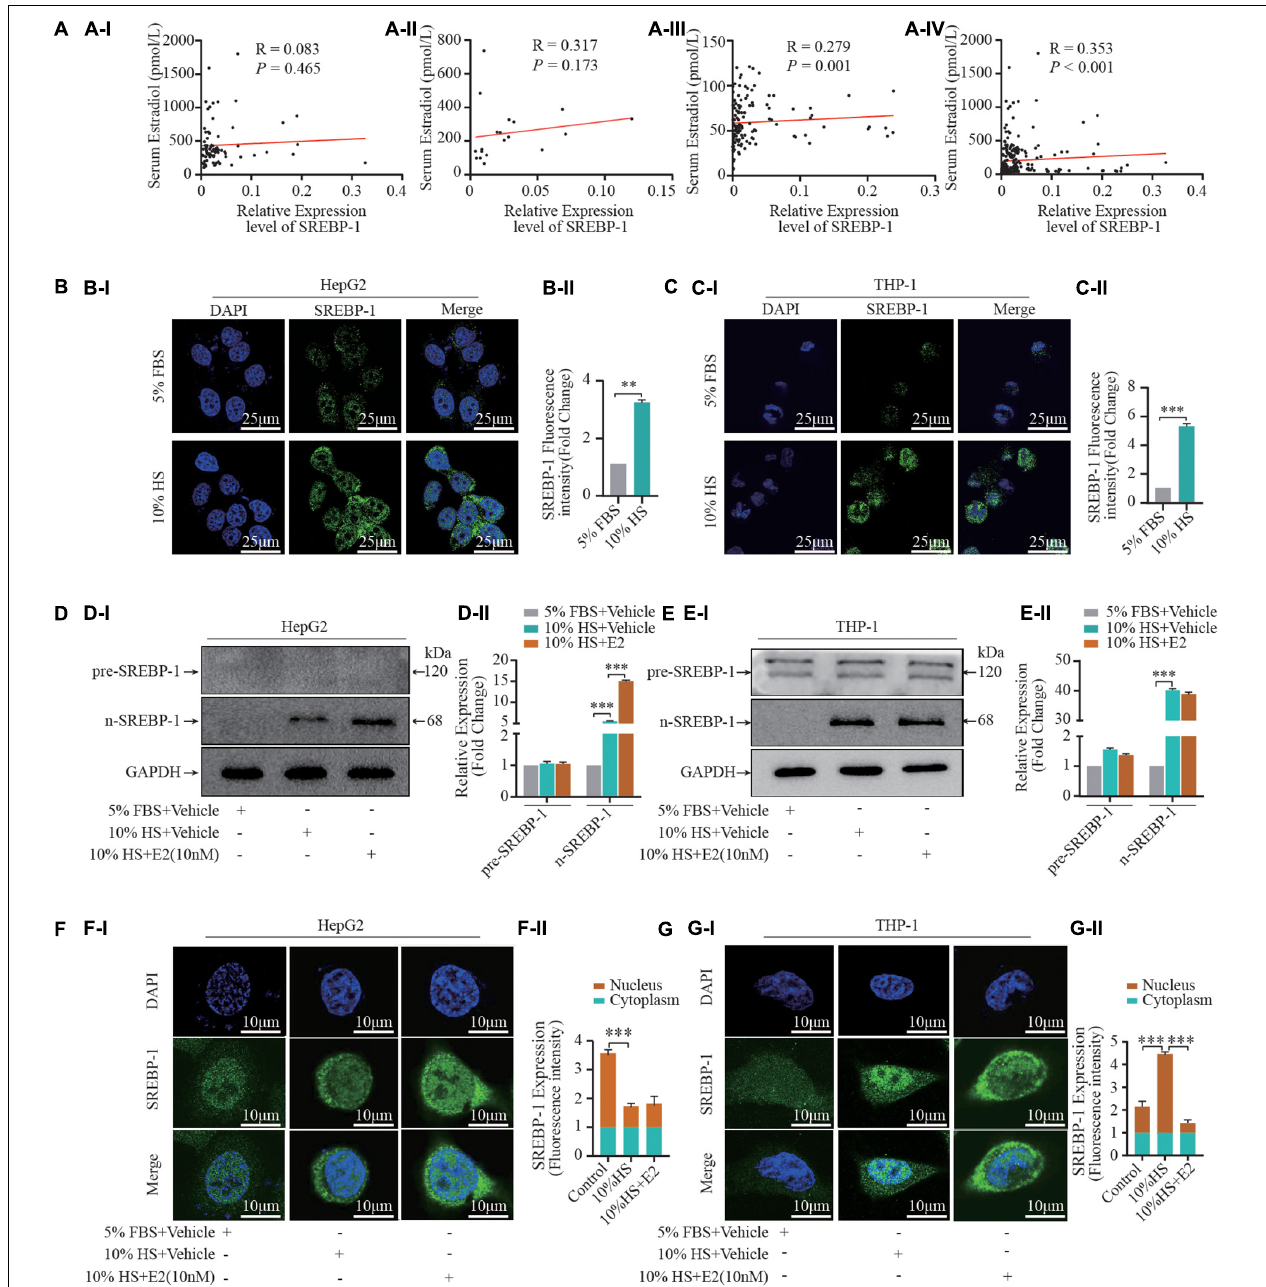
FIGURE 2 | Estrogen influences SREBP-1 expression. (A) A total of 231 healthy women (21–70 years) who experienced natural menstrual states were recruited. The correlation of serum estrogen levels and SREBP-1 mRNA expression in leukocytes in premenopausal (AI) ( n = 80), perimenopausal (AII) ( n = 20), postmenopausal (AIII) ( n = 131) women, and all female participants (AIV) ( n = 231). (B,C) HepG2 and THP-1 macrophages stimulated by 5% FBS and 10% HS for 24 h, SREBP-1 immunofluorescence were visualized under confocal microscopy; DAPI stains the nucleus (blue), SREBP-1 (green) (BI,CI) . Densitometric quantification was conducted using Image J and values are expressed as the fold change compared with control and are presented as mean ± SEM (BII,CII) ( n = 5 ∼ 8 cells/field/slice, n = 3 slices/group). (D,E) Pre-SREBP-1 and n-SREBP-1 were further analyzed by western blot. Densitometric quantification was conducted using Image J and values are expressed as the fold change compared with control and are presented as mean ± SEM (DII,EII) . (F,G) HepG2 and THP-1 cells pretreated with or without 10% HS for 24 h in the presence or absence of E2 (10 nM). Expression and location of SREBP-1 and nuclear SREBP-1 detected by immunofluorescence (FI,GI) ( n = 1 cells/field, n = 5 ∼ 8 fields/slice, n = 3 slices/group), the relative expression intensity in nucleus vs in cytoplasm were illustrated in (FII,GII) . Data illustrated on the bar graph are the mean ± SD. All representative images presented were repeated in three independent experiments. Student’s t -test was used to evaluate the significance in differences between two groups of observations, ∗ P < 0.05; ∗∗ P < 0.01; ∗∗∗ P < 0.001.